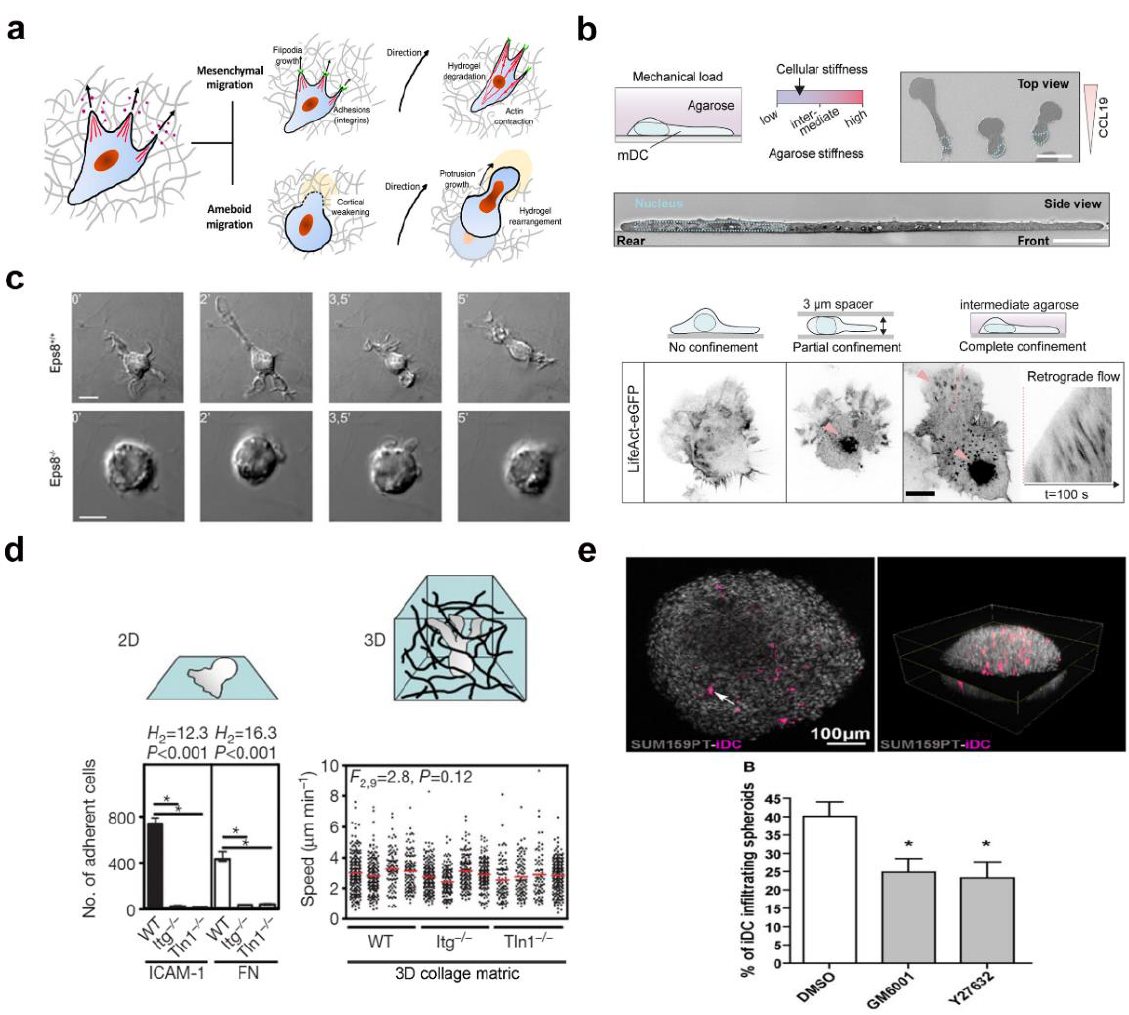
Figure 16. DC migration mode with different dimensionalities and stiffnesses. ( a ) Schematic of mes- enchymal migration and amoeboid migration (reprinted/adapted with permission from Ref. [109], 2021, Franck et al.). ( b ) Confinement of DCs under agarose with different stiffnesses, in which the actin patches form in response to confinement (reprinted/adapted with permission from Ref. [63], 2022, Gaertner et al.). ( c ) Esp8-/- BMDCs fail to extend elongated cell protrusions and migrate in 3D collagen hydrogels. (Reprinted/adapted with permission from Ref. [103], 2011, Emanuela et al.). ( d ) Migration of DCs cultured in 2D and 3D collagen hydrogels (reprinted/adapted with permission from Ref. [14], 2008, Lämmermann et al.). ( e ) DCs adopt both amoeboid and mesenchymal migra- tion in tumor spheroids (* significance level of p < 0.05) (reprinted/adapted with permission from Ref. [110], 2018, Cougoule et al.).